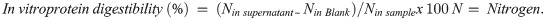
In vitro protein digestibility (%) of pizza with different blends of dried carp fish powder and chickpea flour.Values are means±SD (n = 3), mean represented as bar bearing the different superscript letter are significantly different (p<0.05).
In vitroprotein digestibility (%) = (Nin supernatant_ Nin Blank)/Nin samplex 100 N= Nitrogen.